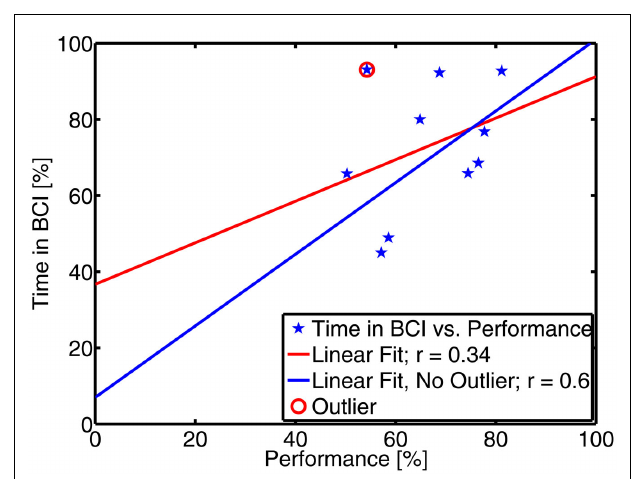
FIGURE 4 | Performance and BCI quality during progress of the whole experiment (A,C) and for one exemplary single run (B,D) for subject S1 who represents a good BCI performer compared to subject S6 as a bad example. The bad performer triggers BCI → JS switches more frequently. Performance depends on currently picked